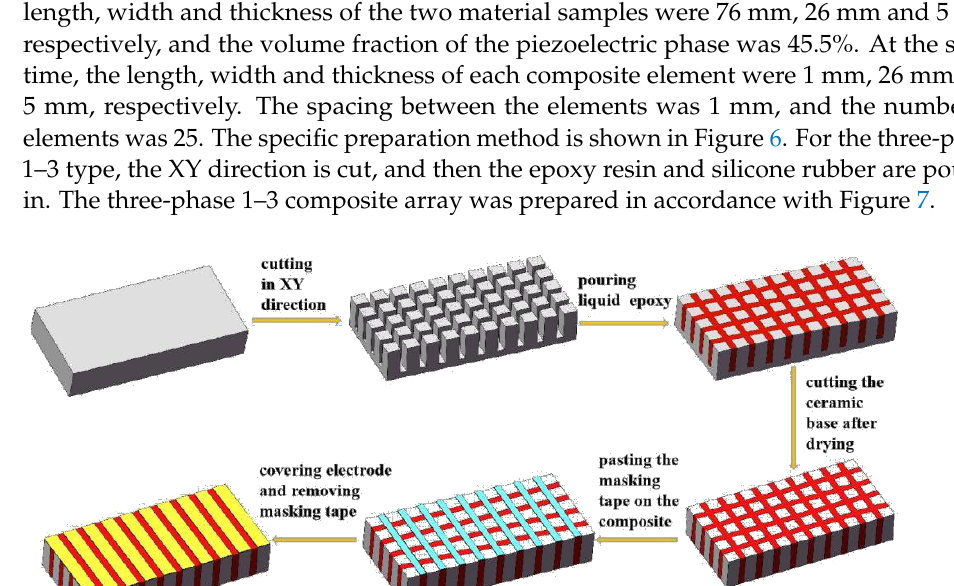
Figure 5. Transmitting voltage response simulation curves of all elements in two types of 1–3 piezoelectric composite array.